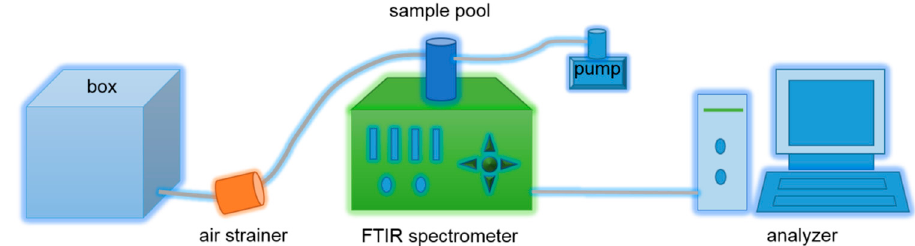
Figure 1. Schematic diagram of greenhouse gas detection system.